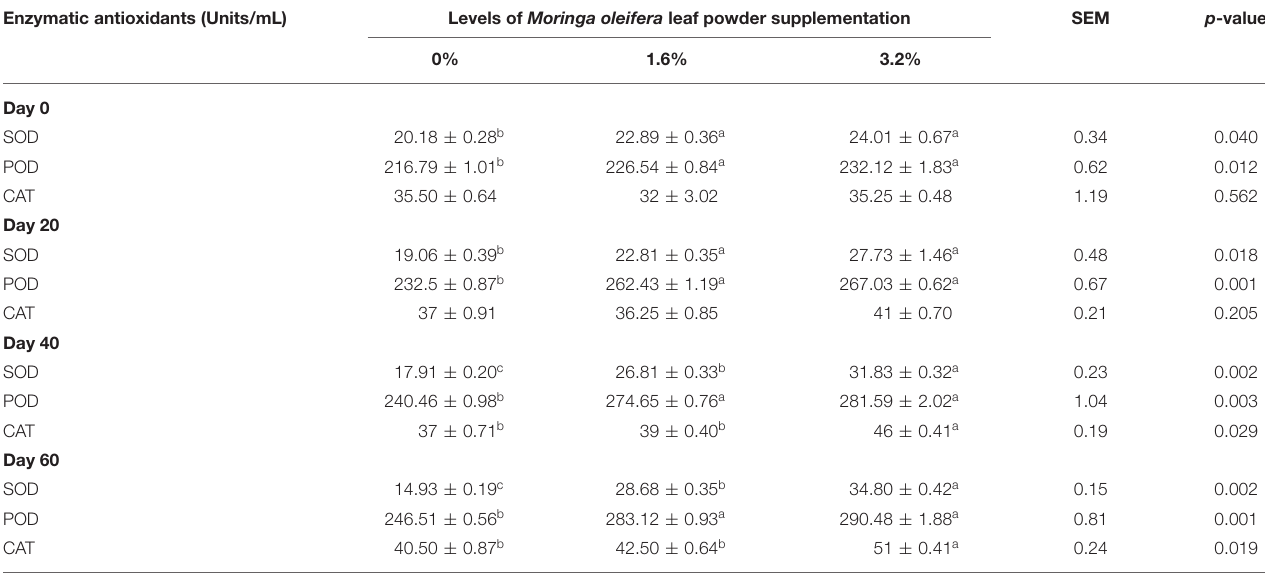
TABLE 5 | Plasma enzymatic antioxidant indices of pregnant beetal goats. Enzymatic antioxidants (Units/mL) Levels of Moringa oleifera leaf powder